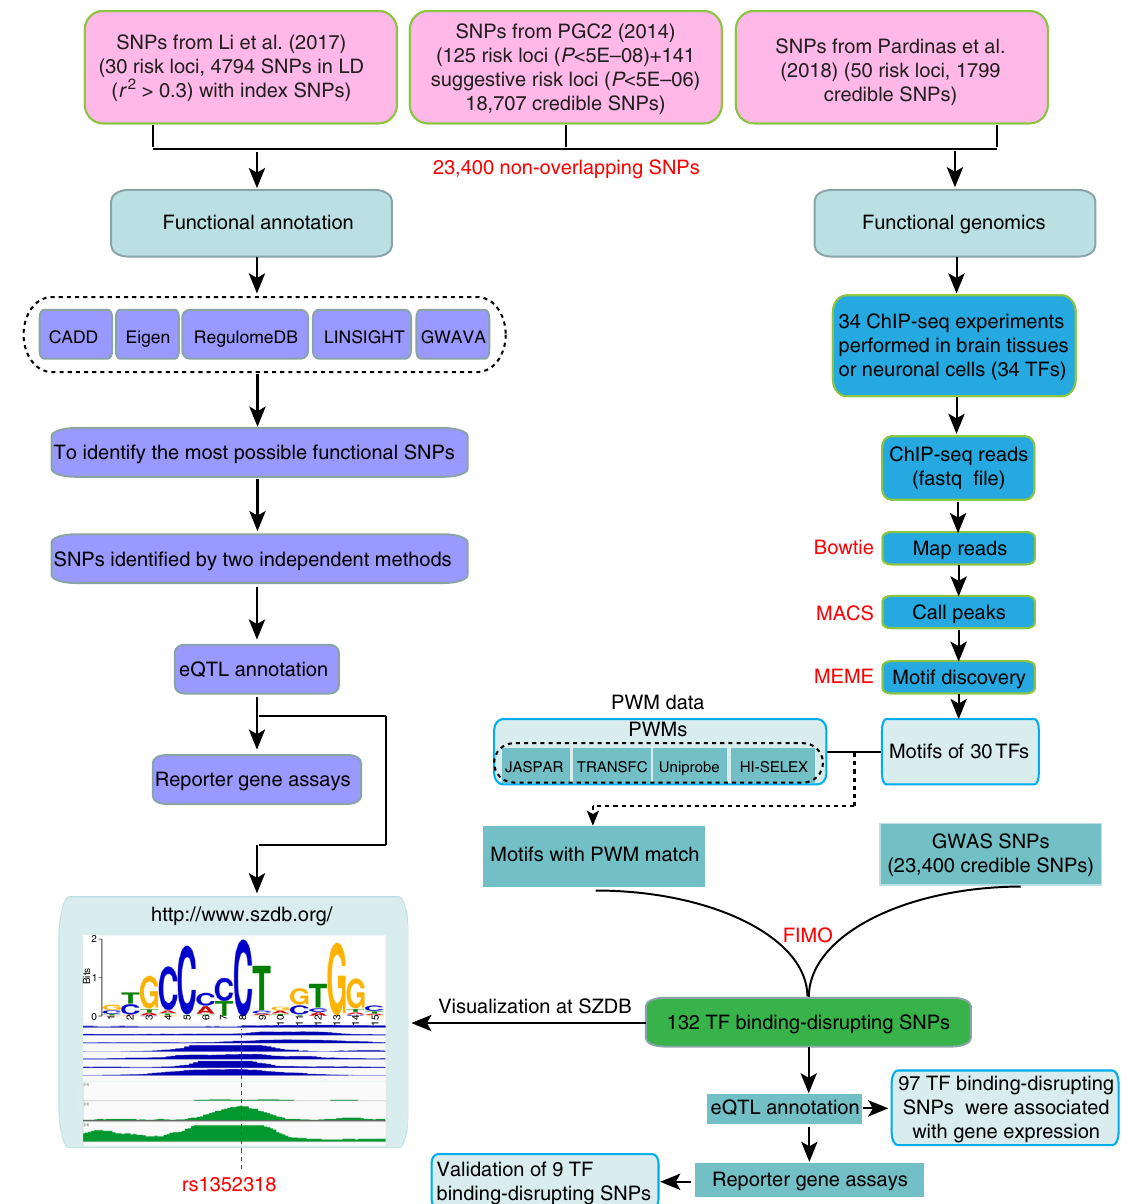
Fig. 1 Prioritization and identi fi cation of regulatory single-nucleotide polymorphisms (SNPs) at schizophrenia risk loci. Risk SNPs (including credible causal SNPs and SNPs that were in linkage disequilibrium (LD) with the index risk SNPs) from three large-scale genome-wide association studies (GWASs) were subjected to functional annotation and functional genomics analyses. Five annotation methods were used to prioritize the most possible functional (or causal) SNPs (i.e., SNPs with the largest scores (CADD, Eigen, LINSIGHT and GWAVA) or the lowest rankings (1a, RegulomeDB)). The most possible functional SNPs (we call these SNPs top functional SNPs) were further distilled and the same top functional SNP prioritized by at least two different annotation approaches was subjected to expression quantitative loci (eQTL) annotation and reporter gene assays. We also utilized functional genomics to identify the potential causal SNPs at the risk loci. Chromatin immunoprecipitation and sequencing (ChIP-Seq) experiments performed in brain tissues or neuronal cell lines were used to identify the motifs (i.e., position weight matrices (PWMs) of corresponding transcription factors (TFs)). The identi fi ed PWMs from ChIP-Seq experiments and PWM database were compared, and the matched PWMs were used to map if the risk SNPs were located in the identi fi ed PWMs. Reporter gene assays were used to validate the effects of the identi fi ed TF binding – disrupting SNPs and eQTL annotation was performed to identify the potential target genes of the identi fi ed regulatory SNPs. The results of this study can be accessed and visualized at SZDB database (http:// (dorsolateral prefrontal cortex, N = 412, including 175 patients with schizophrenia and 237 unaffected controls) (http://eqtl. original papers were used in this study, i.e., FDR < 0.05 in CMC, brainseq.org/phase1/eqtl/), the Genotype-Tissue Expression FDR < 0.01 in LIBD). We used P < 0.001 for GTEx) with gene (GTEx) 34 (tissues were from 13 brain regions, N ranges from 80 to 154) (Supplementary Table 3) and the CommonMind